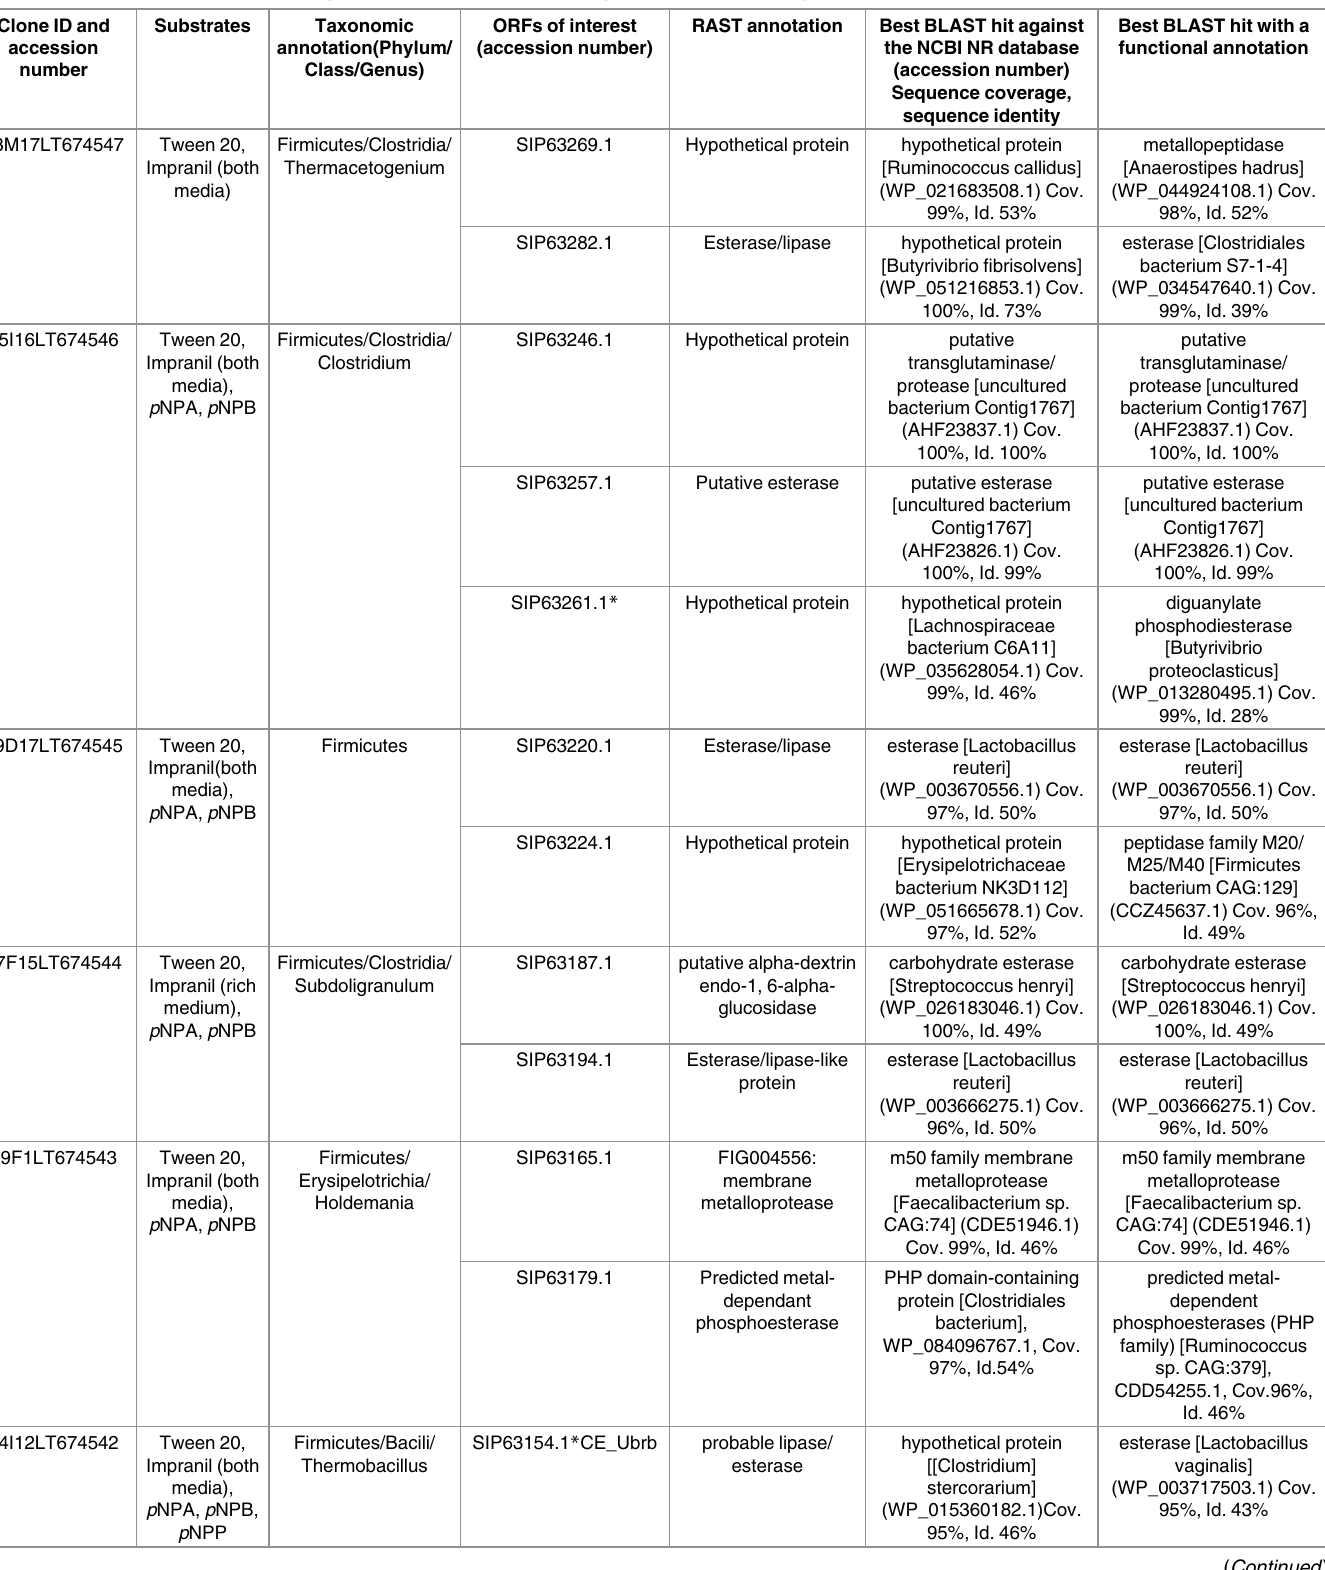
Table 1. ORFs of interest from the sequenced clones, annotated as putative esterases or proteases. Clone ID and accession